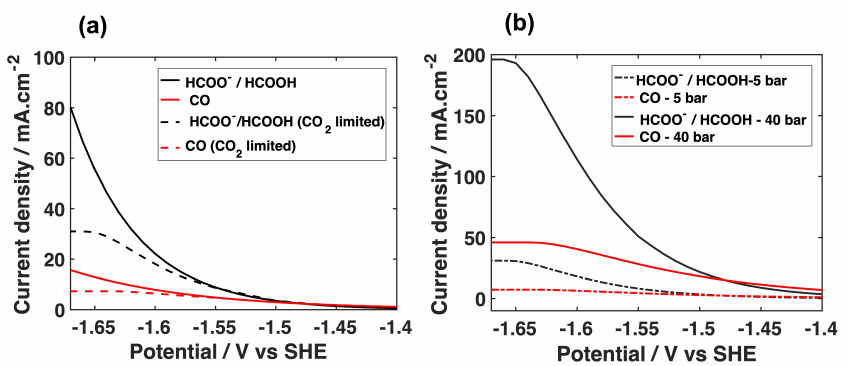
Figure 5. ( a ) The potential dependent partial current density of formate/formic acid and CO forma- tion with and without applying CO 2 mass transport resistance. The current density without mass transfer resistance is calculated assuming that the CO 2 concentration at the electrode surface is equal to bulk at all voltage. For the mass transfer affected current density, the surface concentration is updated for every applied potential; ( b ) effect of CO 2 pressure on maximum achievable current density for formate/formic acid and CO at 5 and 40 bar,